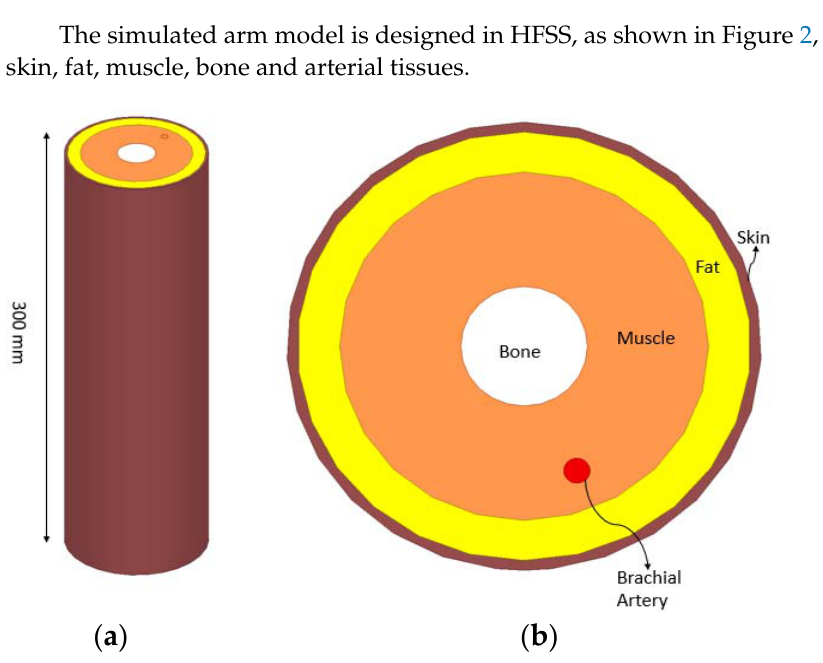
Figure 2. Cylindrical modeled multi-layer human arm model developed in ANSYS HFSS: ( a ) per- spective view; ( b ) cross section of the top view (zoomed in).